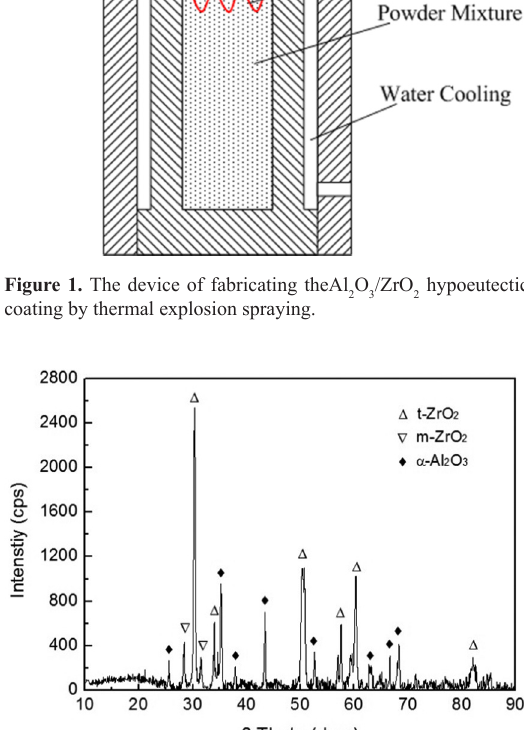
O -ZrO coating. 2 3 2